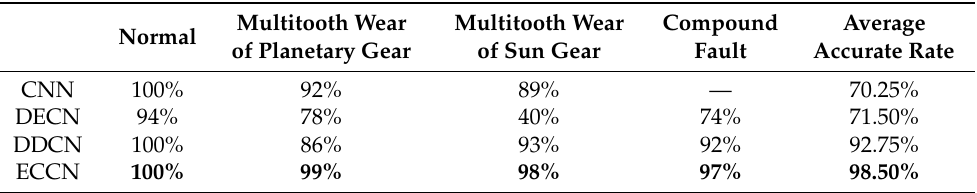
Table 3. RV reducer data classification